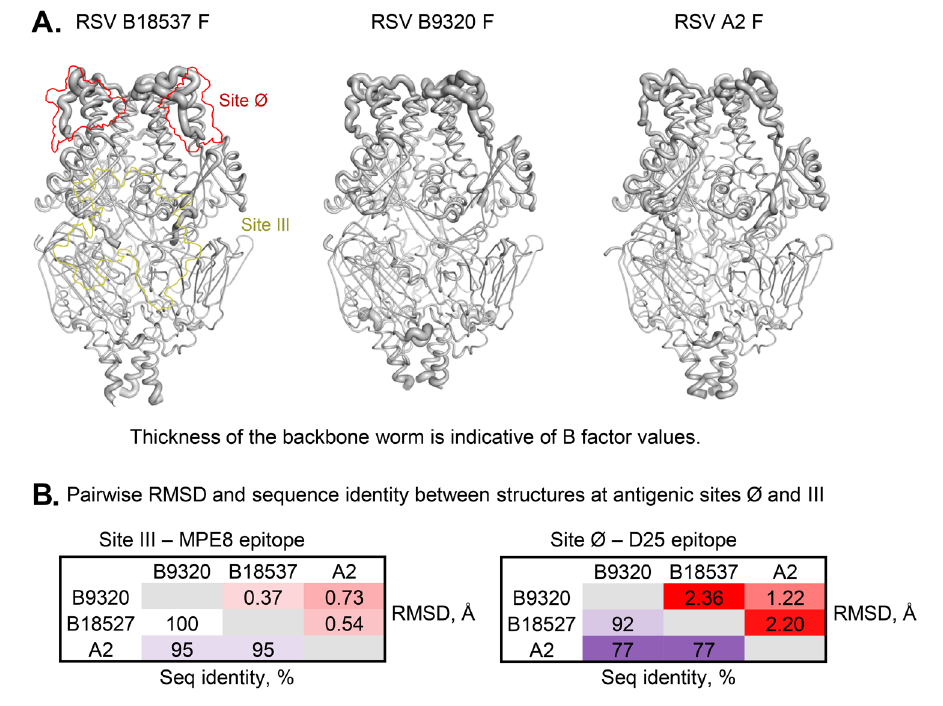
Figure 4. DS-Cav1 stabilized RSV F glycoproteins have higher flexibility at the apical region . (A) Worm diagrams of the RSV F trimers with thickness proportional to B factor values. The figures were prepared with PyMOL from crystal structures of B18537, B9320 (5UDE), and A2 (4MMU). The positions of antigenic sites Ø and III on the front face are marked with red and pale-yellow contours on the diagram of the B18537 structure. (B) Pairwise RMSD between the 3 structures at 2 antigenic sites with the corre- sponding sequence identity of the epitope residues. RMSD was calculated based on C α